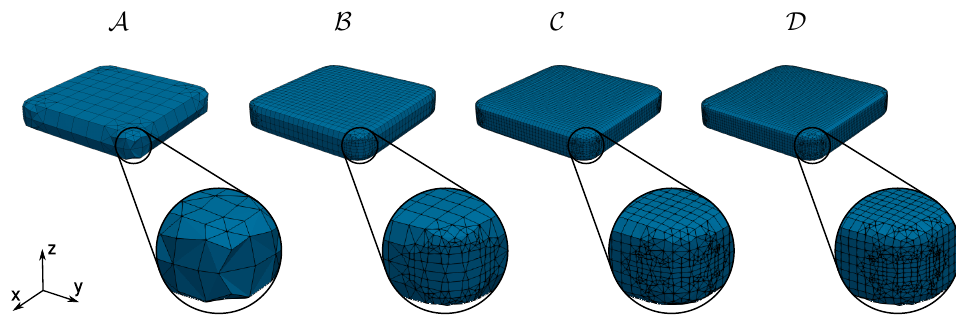
Figure 4. Surface meshes A , B , C and D on the example of rectangular disc particle. Mesh elements in the bottom right corner of the particle are displayed in magnified detail, to show the quality of the captured rounded edge.